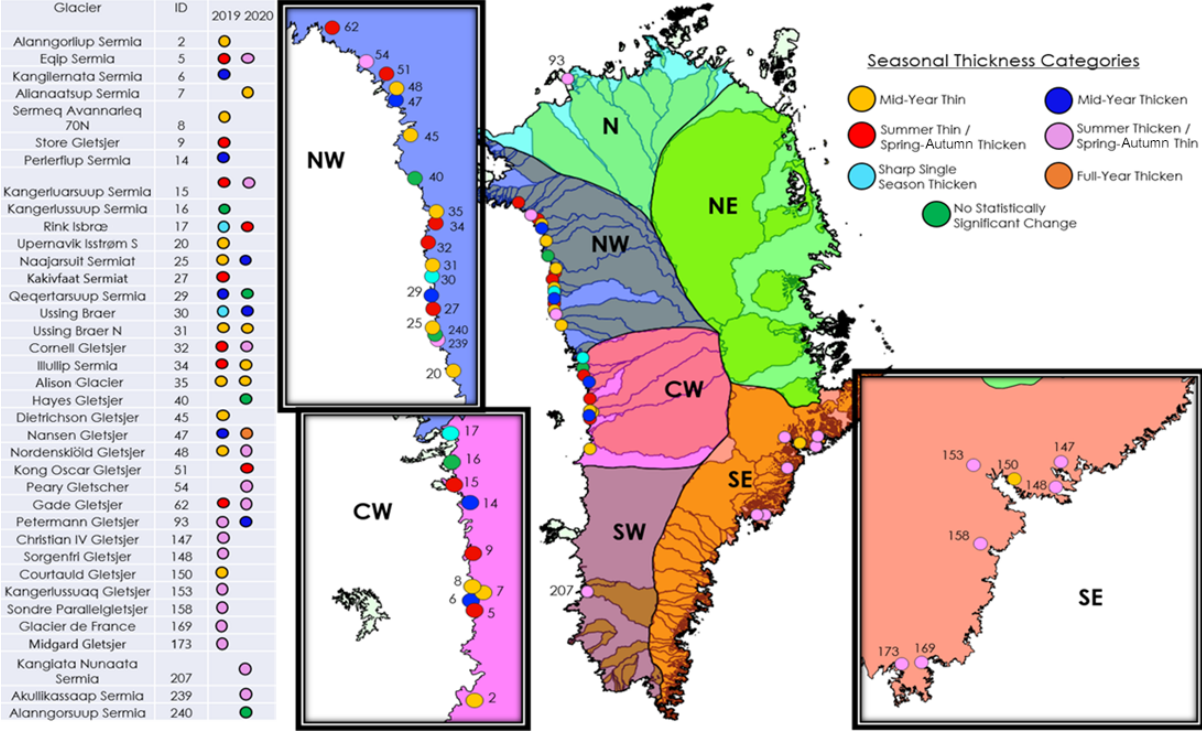
Figure 2. Locations, patterns of seasonal dynamic thickness change, and average ice speeds of 37 GrIS outlet glaciers. Glaciers with different patterns in 2019 and 2020 are depicted on the ice sheet map with their 2019 pattern coloration, while both 2019 and 2020 patterns are shown in their yearly pattern in the left-side